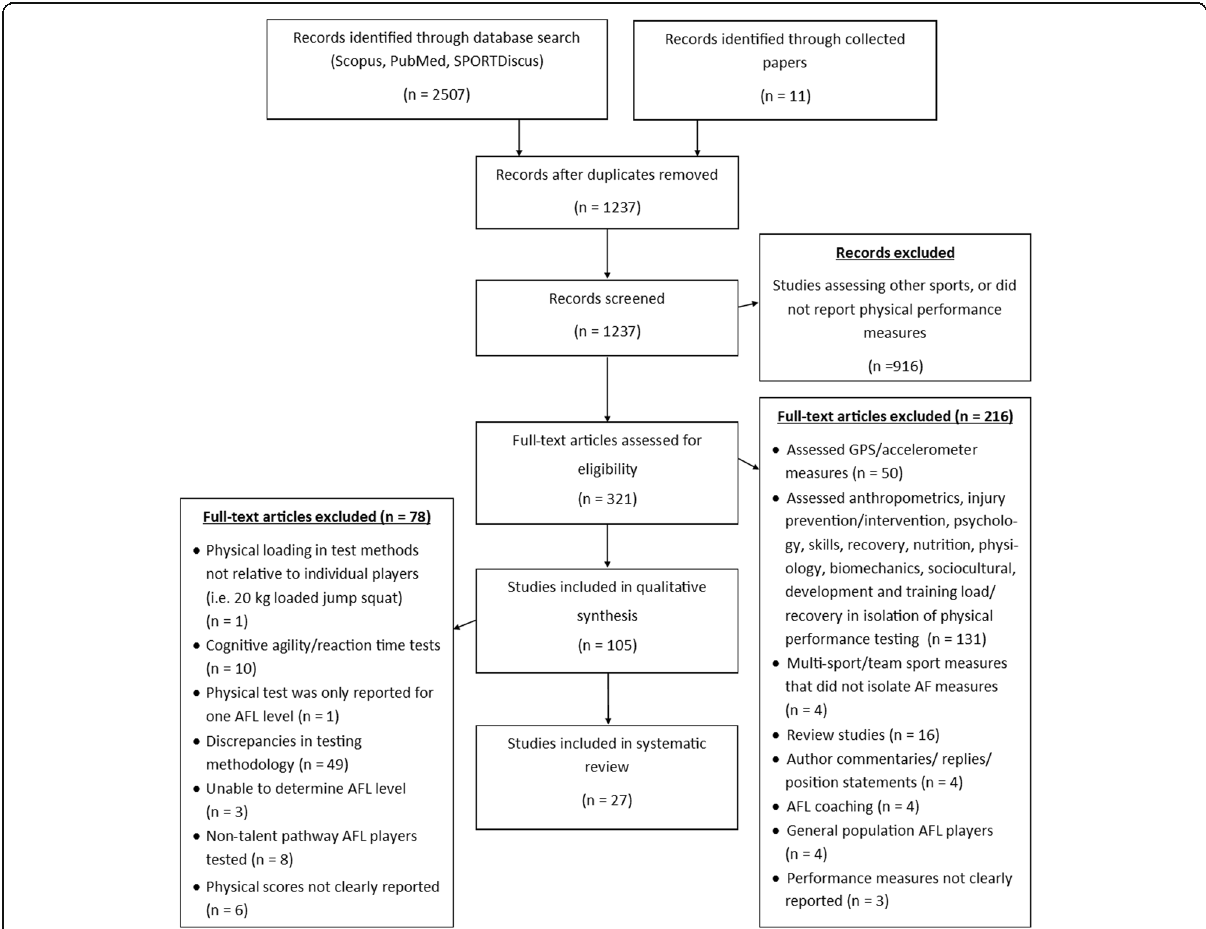
Fig. 2 PRISMA flow diagram of study search strategy for systematic review of AFL development pathway. AF Australian Football, AFL Australian Football League, GPS Global Positioning